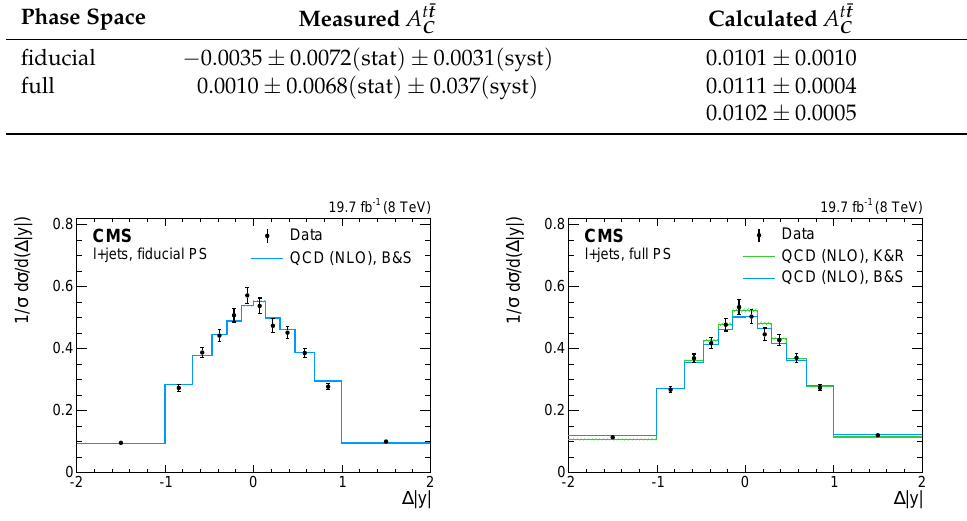
Figure 16. Unfolded inclusive ∆ | y | distributions in the fiducial and full phase spaces [50] compared with NLO predictions from the SM